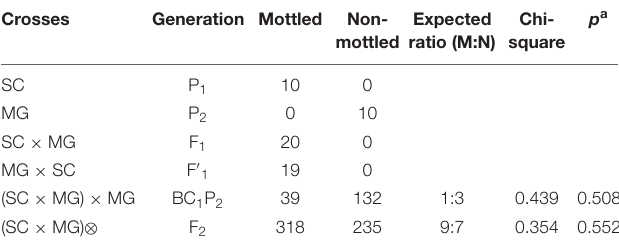
TABLE 1 | Inheritance of the mottled rind in melon.